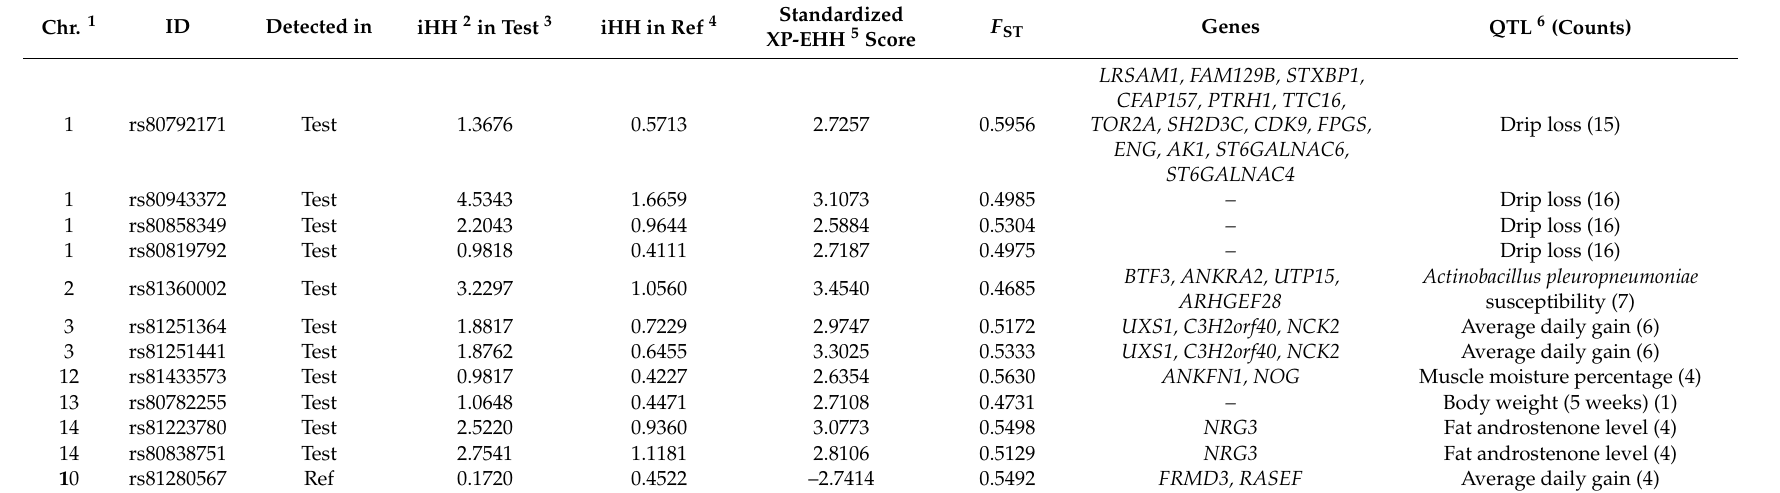
Table 2. Summary of significant SNPs detected simultaneously by two methods in the Ding’an and Tunchang / Saba pig